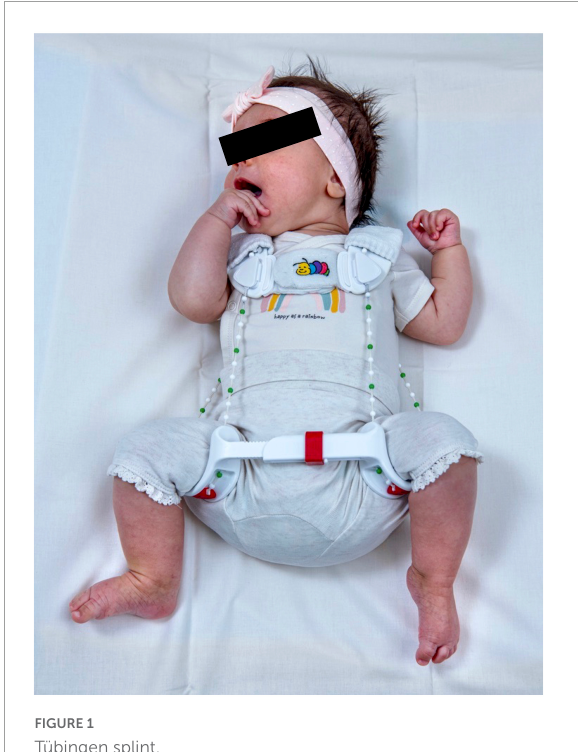
FIGURE1 Tübingen